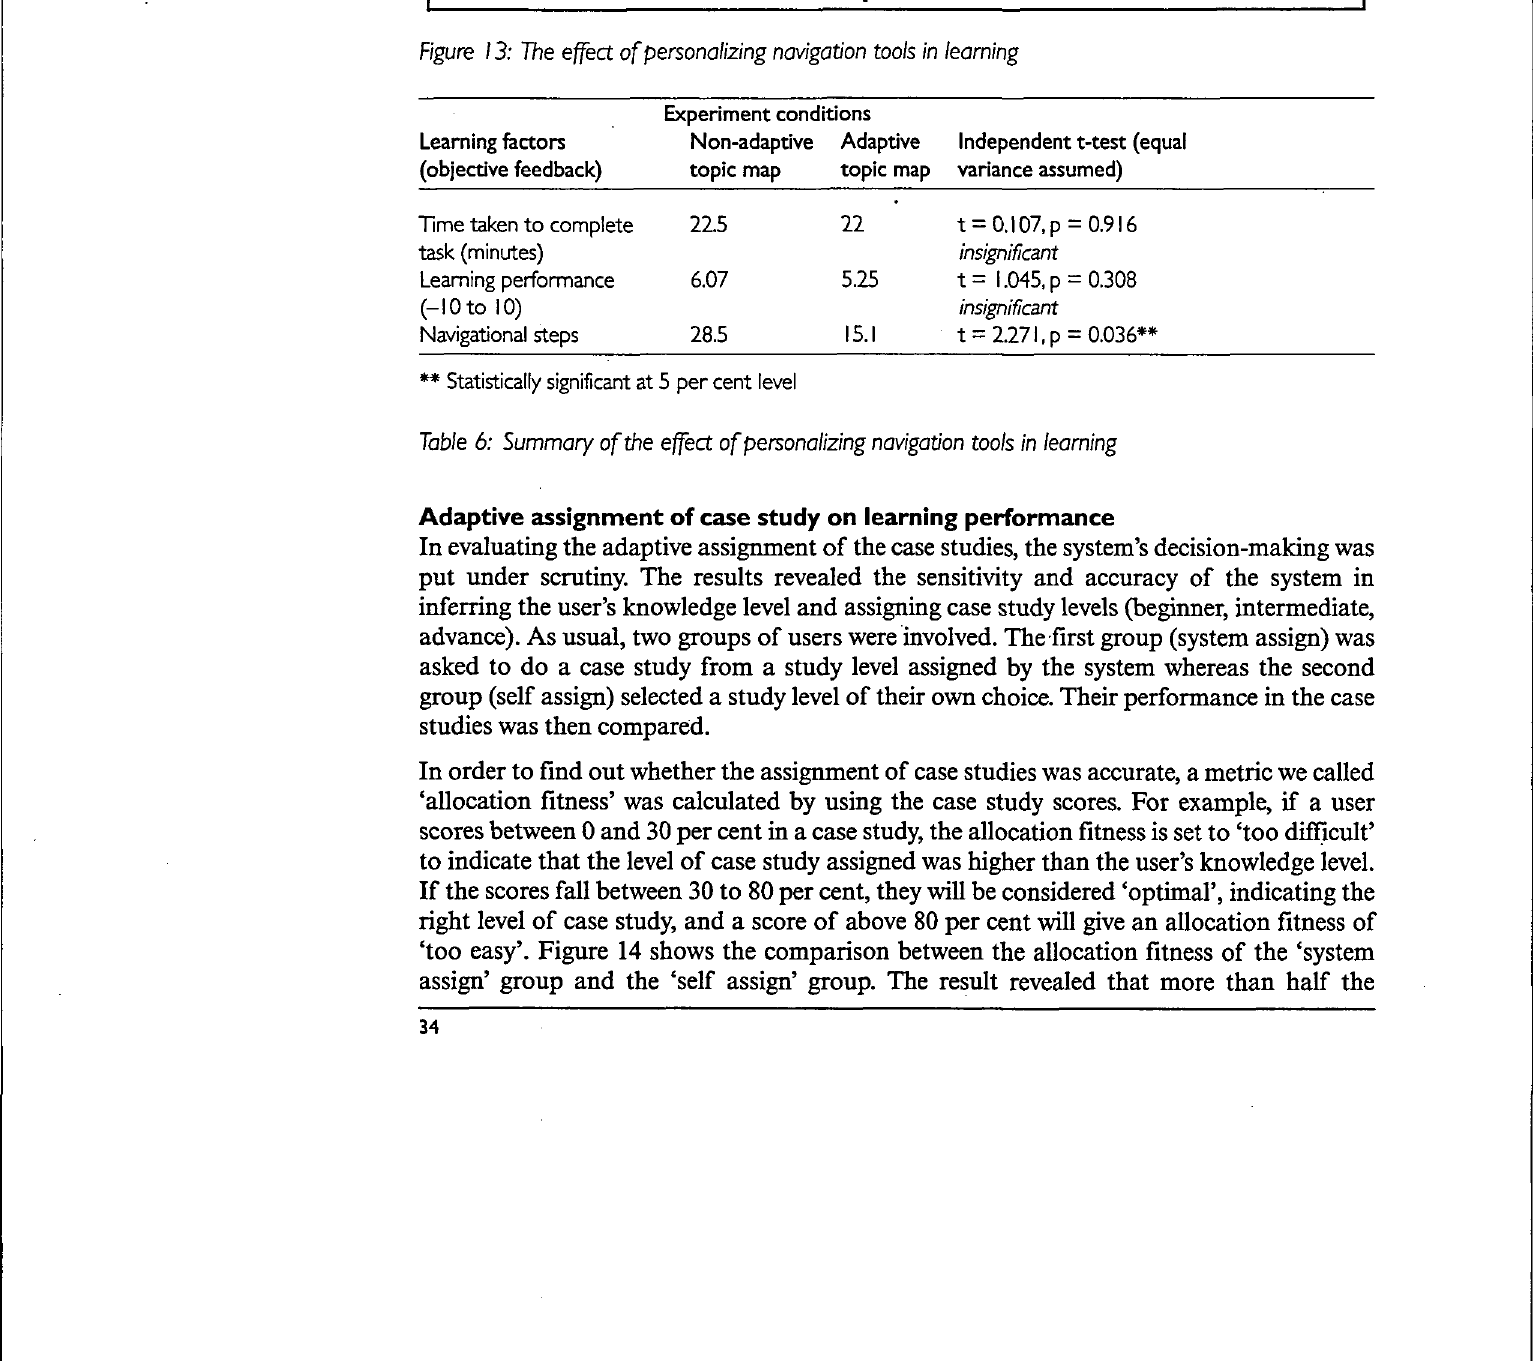
Figure 13: The effect of personalizing navigation tools in learning